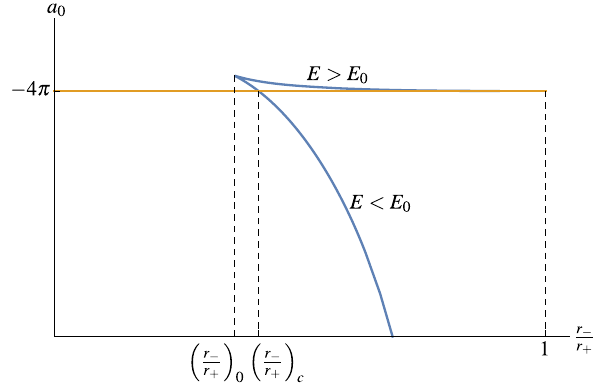
Fig. 15 The coefficient a catenoid as a function of the ratio of the radii 0 of the boundary circles. The singular point of the curve corresponds to E = E